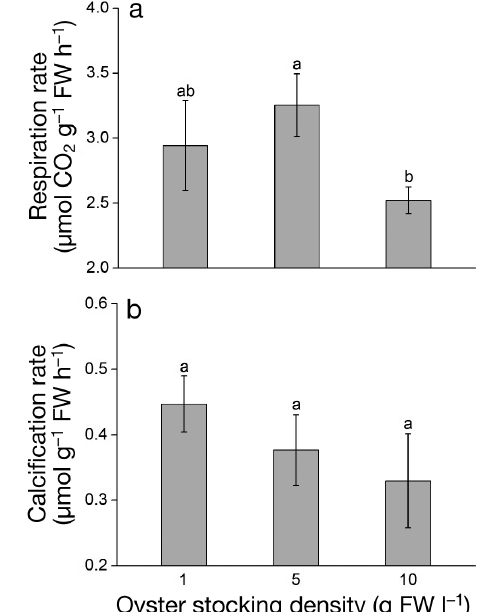
Fig. 3. (a) Respiration and (b) calcification rate of the Por- tuguese oyster Crassostrea angulata at different stocking densities. Bars with different lowercase letters are signifi- cantly different (ANOVA, p <